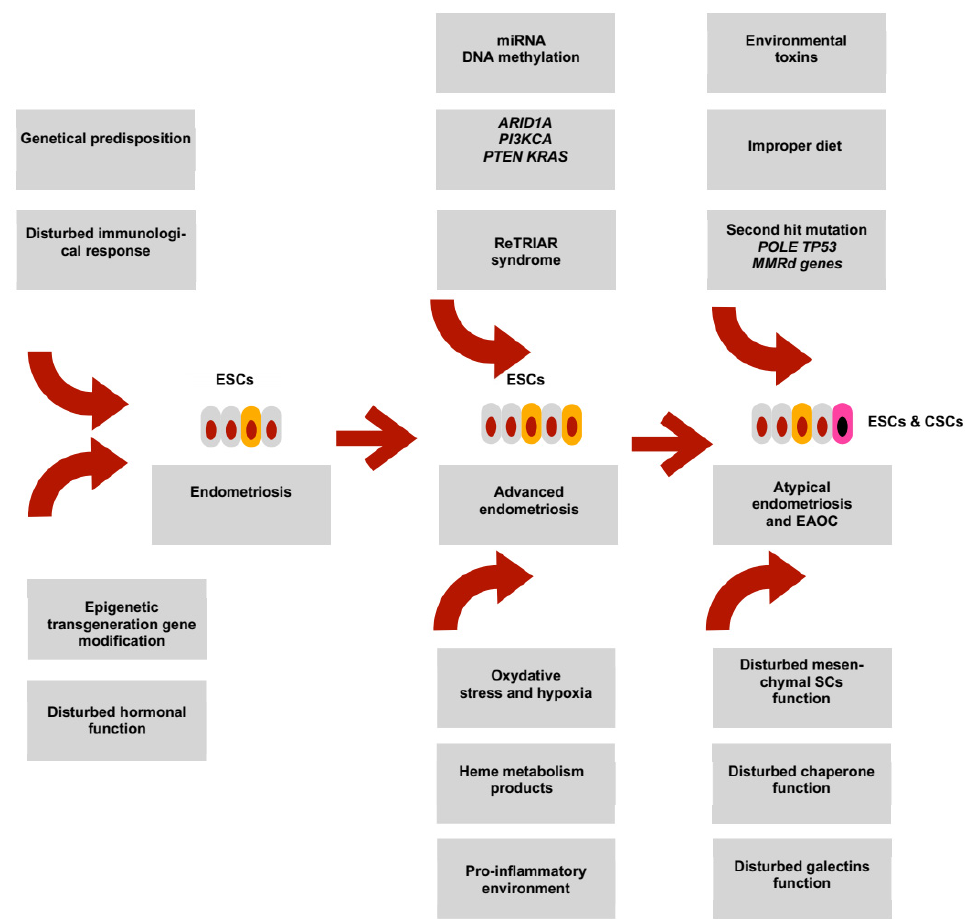
Figure 2. A hypothetical sequence of events leading from beginning of endometriosis towards its malignant transformation. In women presenting with a genetic predisposition or having epigenetic transgenerational gene modification endometriosis could emerge inside the peritoneal cavity, tubes and ovaries. Disturbed hormonal function (estrogenic stimulation) and ineffective immunological response enhance the chances for progressive growth of endometriotic lesions. Endometriosis epithelial stem cells (ESCs) originating either from endometrial stem cells or from bone marrow-derived stem cells are present inside endometriotic lesions. The prolonged existence of endometriotic foci leads to changes that could push ESCs to increased proliferative and functional activity. The mechanisms that contribute to these changes involve the occurrence of driver mutations (ARID1A, PI3KCA, PTEN, KRAS), ReTRIAR syndrome, epigenetic regulation by miRNA and DNA methylation. All these changes support the proliferative activity and migration potential of ESCs. Moreover, the DNA of the endometriotic ESCs could be damaged by a hostile environment composed of oxidative chronic stress, hypoxia, products of heme metabolism and a pro-inflammatory setting. These are known stimuli sustaining the function and survival of stem cells. Finally, in the group of elderly patients with non-treated endometriosis the progression into endometriosis-associated ovarian cancer (EAOC) takes place. The origin of EAOC is probably dependent on several trigger mechanisms influencing ESCs cells. One of the most probable events is so-called “second hit” mutation which destabilizes genetically ESCs with previous ARID1A or other mutations. Other triggers could be disturbed chaperone and galectins functions. One of the most relevant stimuli originates in our opinion from disturbed mesenchymal SCs function. These cells present inside the stroma of endometriotic lesions support proliferative activity and probably stemness of epithelial ESCs. Exposition to environmental toxins or improper diet components could be the final step in changing the ESCs into cancer stem cells (CSCs), and endometriosis into atypical endometriosis or